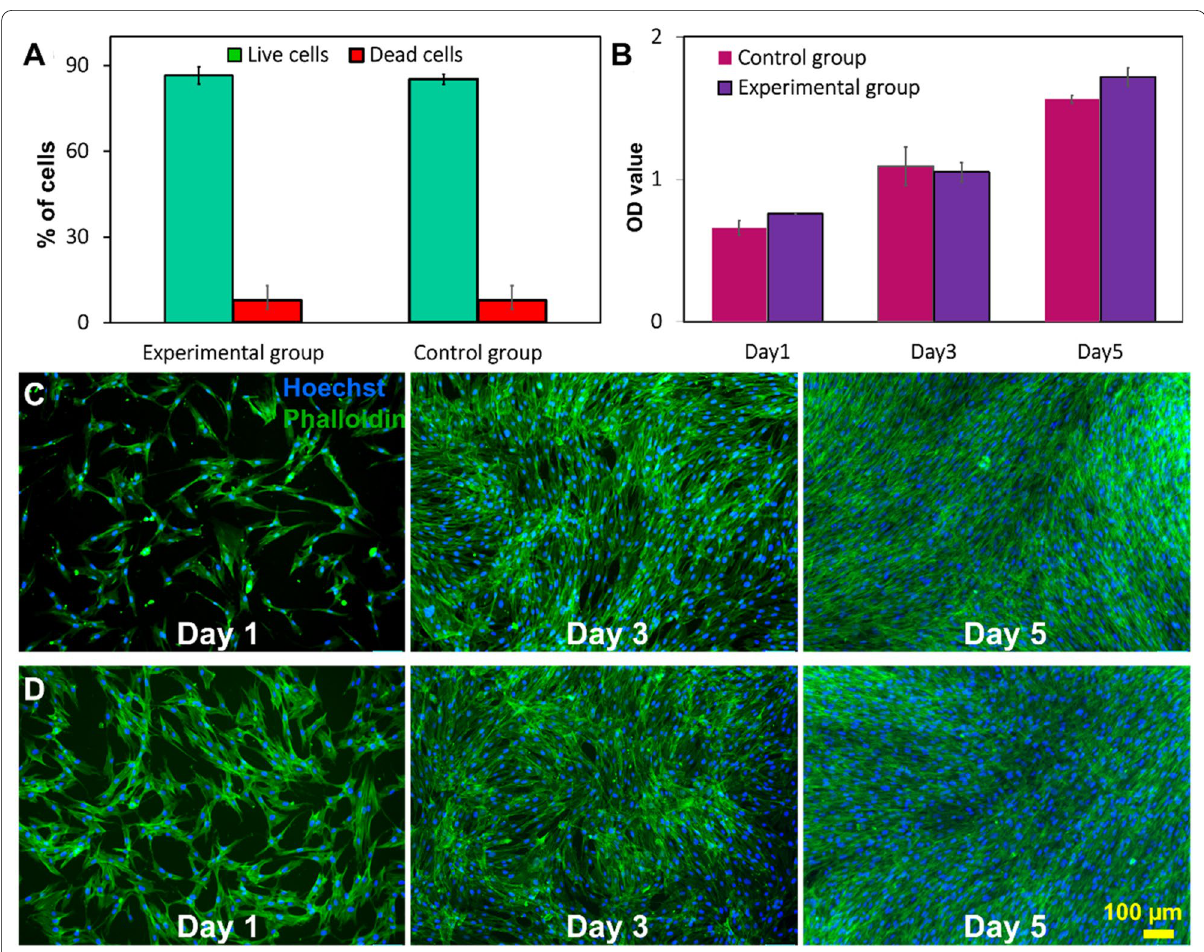
Fig. 4 Viability and proliferation of MSCs after harvesting process. A The viability of cells harvested by the microfluidic system and filtration method. Cell viability did not change significantly compared with the control group. Data are presented as